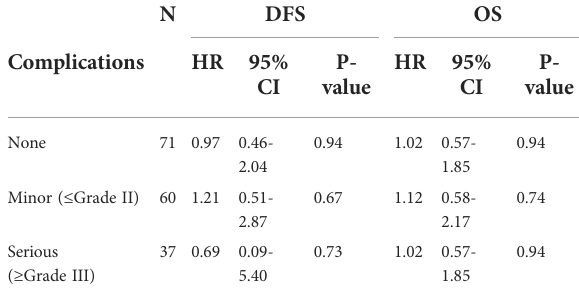
TABLE 6 Effect of MIE on disease-free survival and overall survival in participants with different complications grade relative to